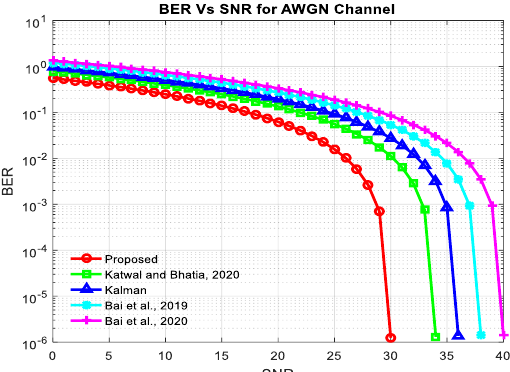
Figure 5. BER vs. SNR analysis in AWGN channel